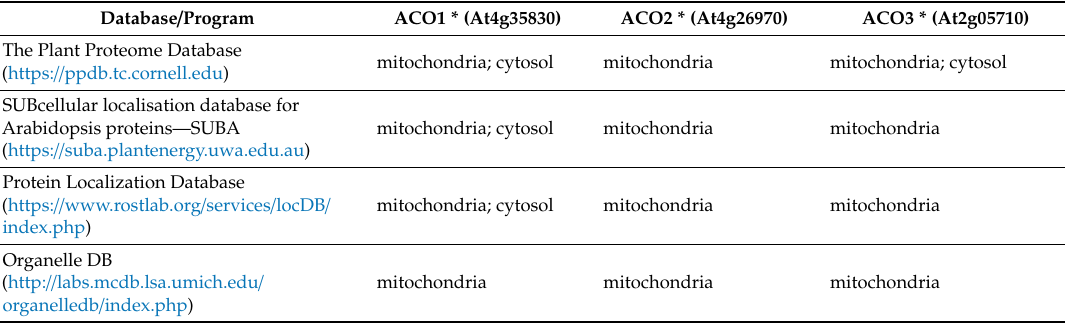
Table 1. Prediction of the intracellular localization of Arabidopsis aconitase protein by different available databases.